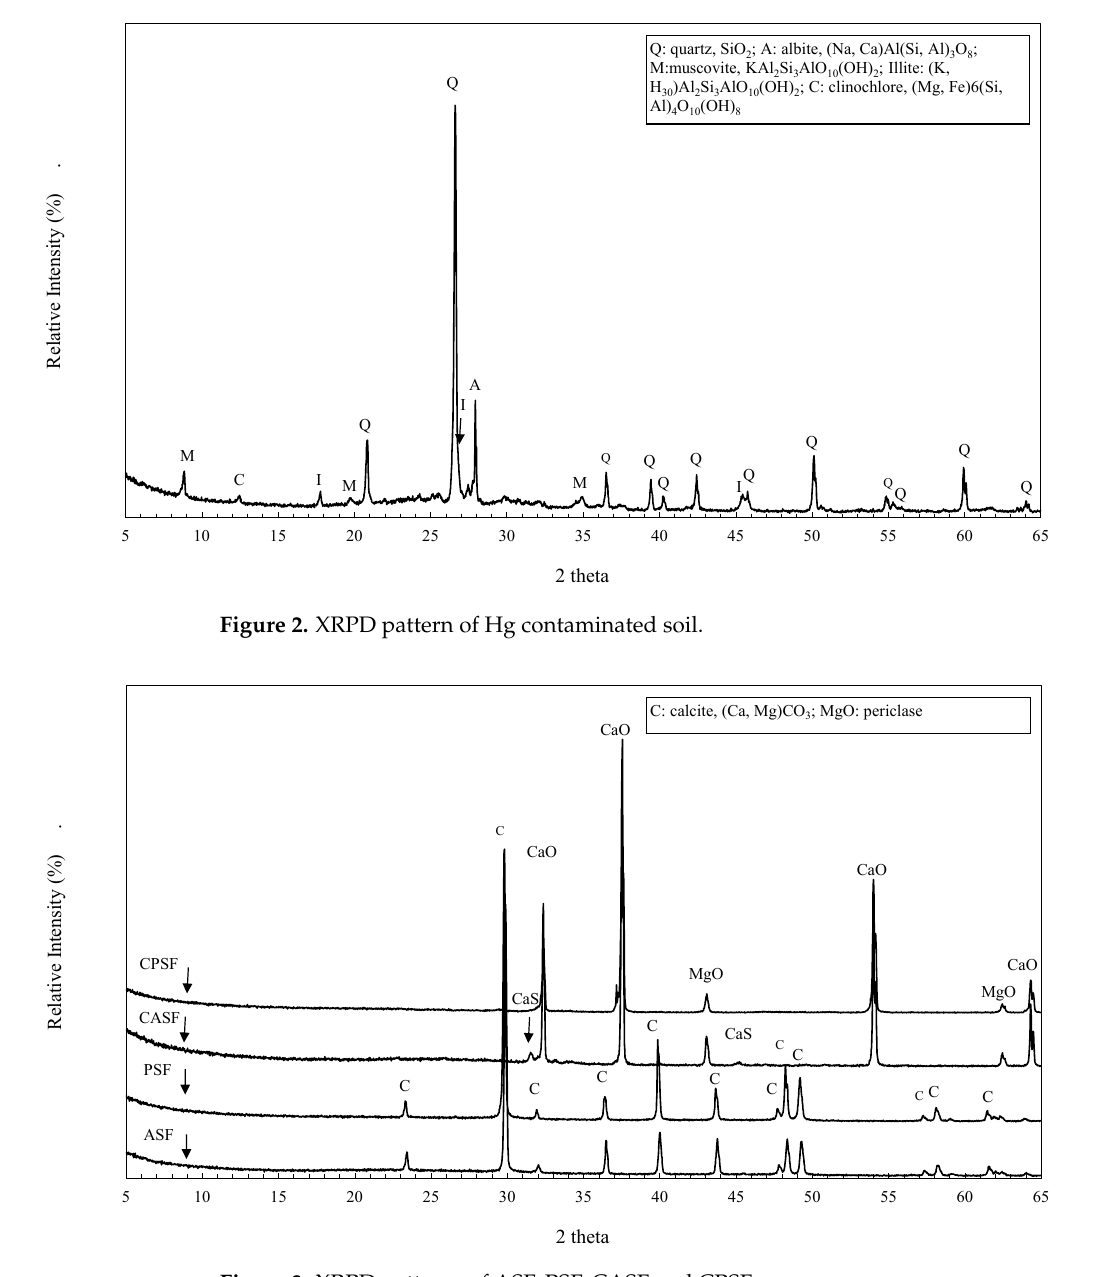
Figure 3. XRPD patterns of ASF, PSF, CASF and CPSF.